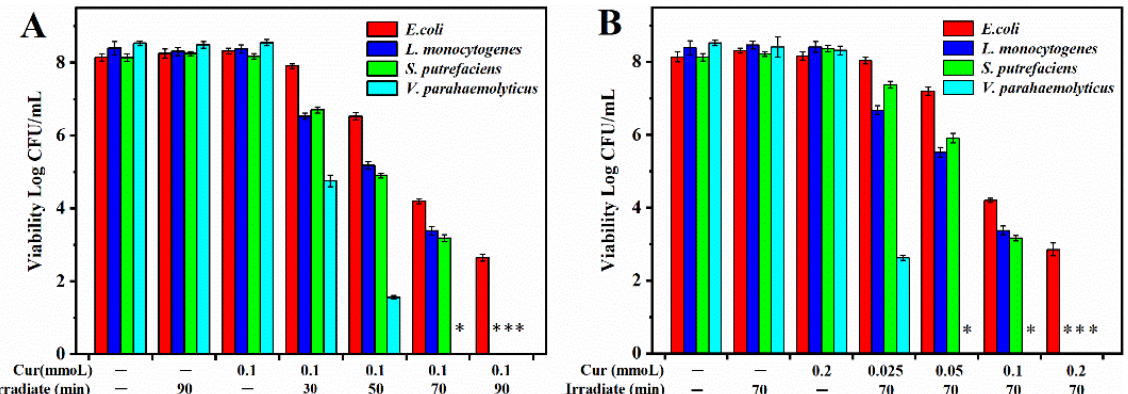
Figure 7. Antibacterial effect of the PDI-treated composite films against E. coli , L. monocytogenes , S. putrefaciens , and V. parahaemolyticus at different illumination times ( A ) and Cur concentrations ( B ). * Indicates absence of growth.